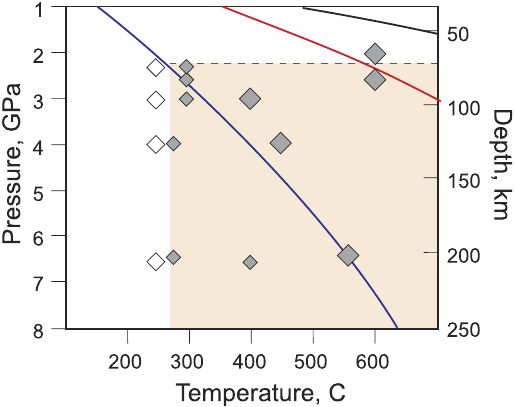
Figure 2. Experiments and geotherms 20 . The blue curve is a cold slab, the red curve is a hot slab, and the black curve is the upper mantle pT profiles. The white diamonds depict experiments where hydrocarbons are not detected. The small gray diamonds correspond to experiments with a low hydrocarbon yield. The big gray diamonds correspond to experiments with a high hydrocarbon yield. The error bars are smaller than the symbol size. The pink sector indicates the thermobaric zone where hydrocarbon formation is